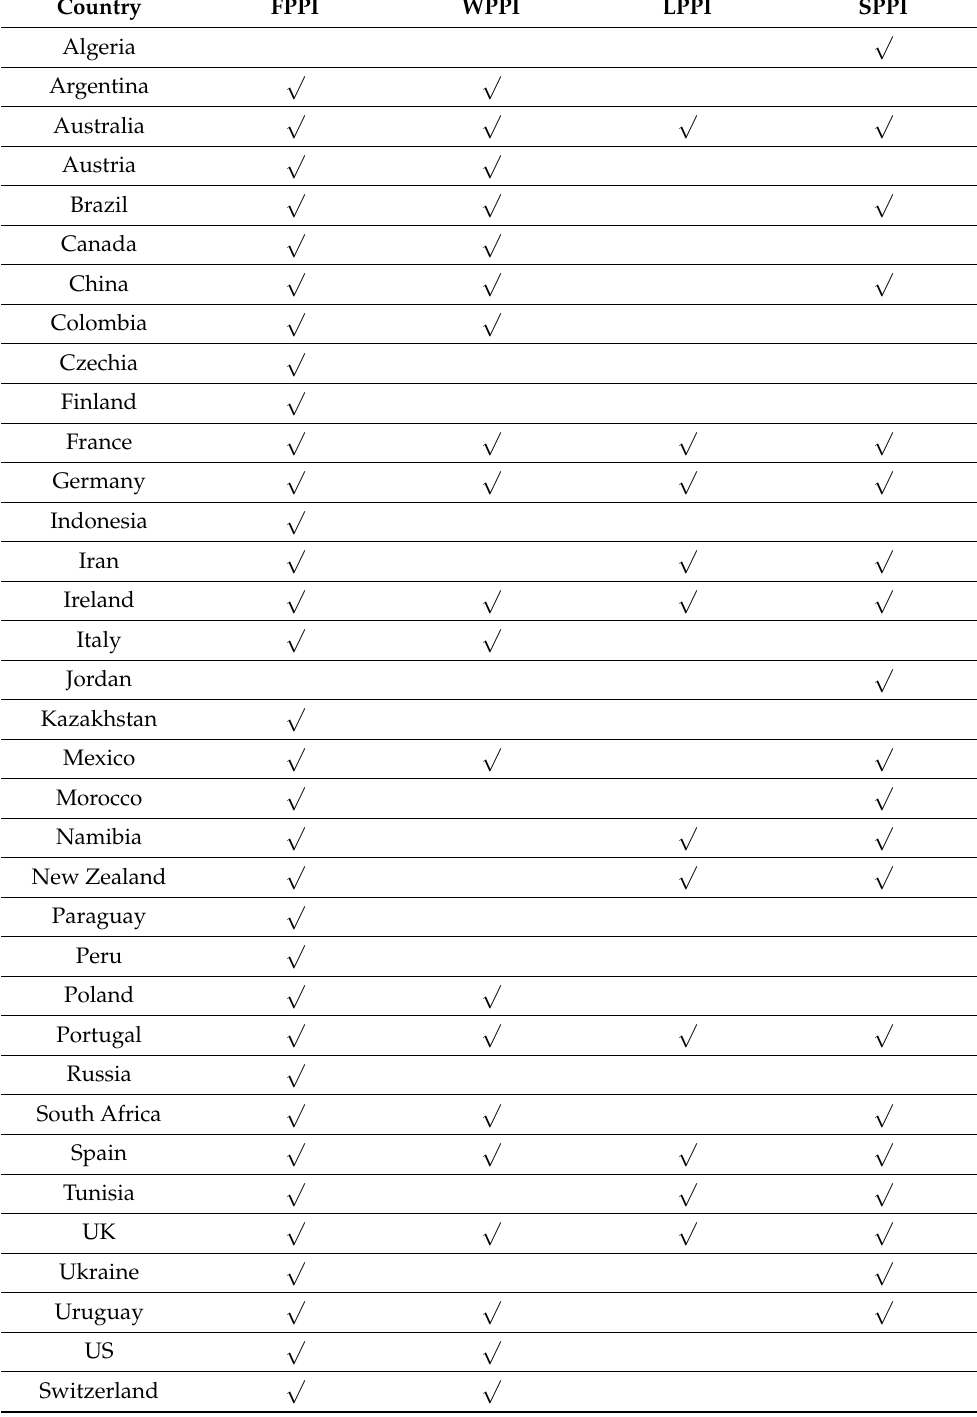
Table A1. Countries included in each of the producer price indices, source: own